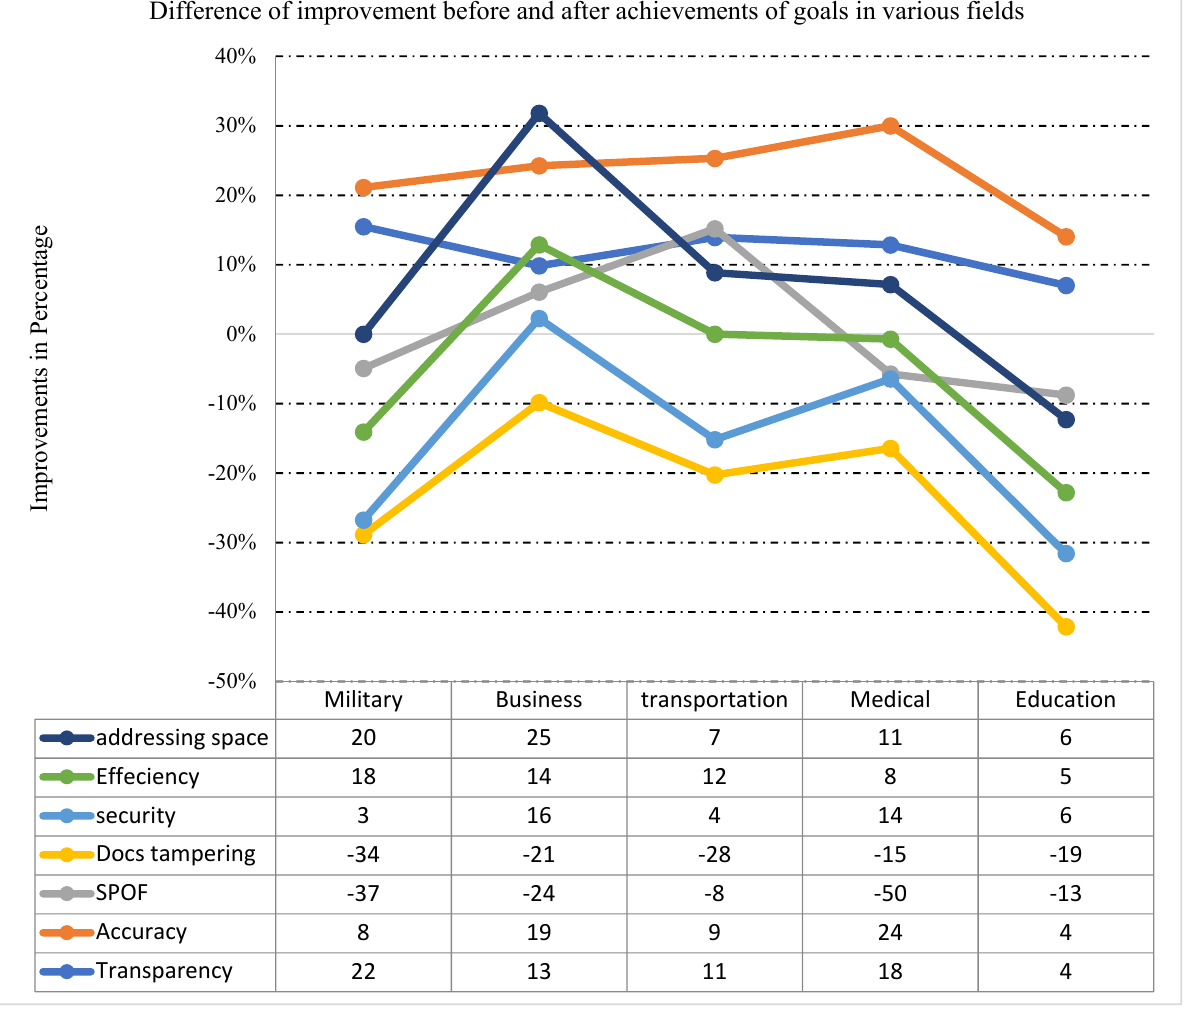
Figure 16. Difference between Figures 13 and 14, shown graphically.